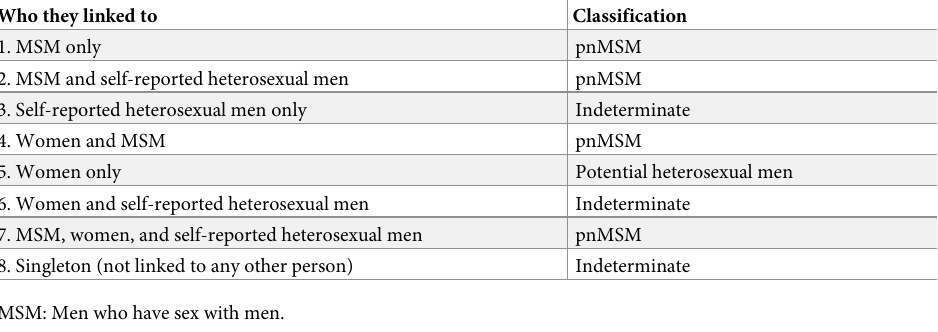
Table 1. Classification of self-reported heterosexual men based on who they were linked to in the same network. Who they linked